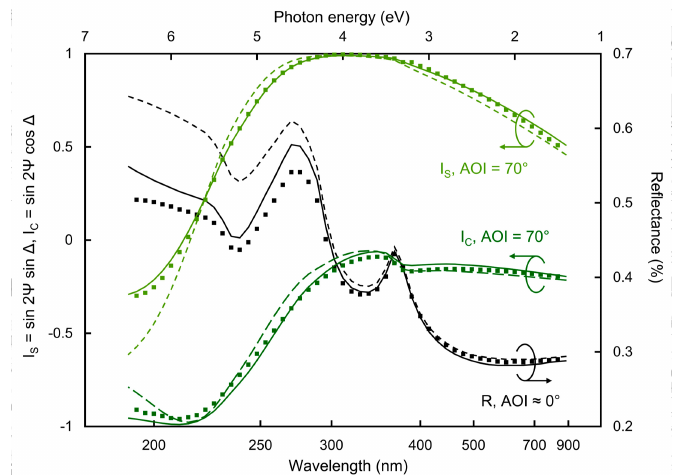
Figure 3. The measured ellipsometric parameters, I S and I C , at an angle of incidence of 70 ◦ , and the measured near-normal reflectance for 5000 cycles of LiF deposition at a substrate temperature of 150 ◦ C (symbols). The best simultaneous fit for a single optical layer (dashed line) is shown, along with the best fit for an additional layer to approximate surface roughness effects (solid